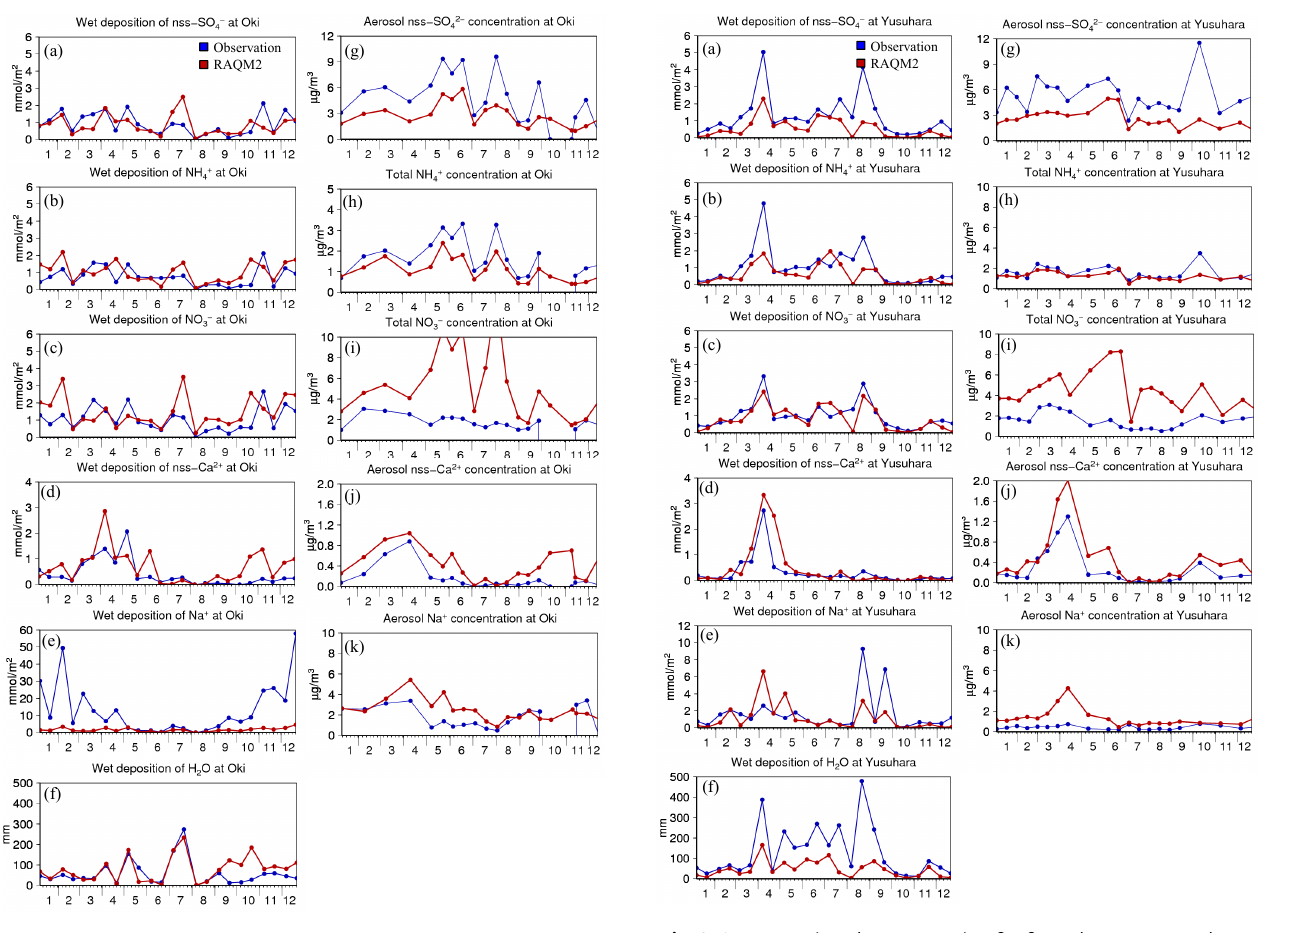
Fig. 6. Same as Fig. 5 but at a station far from the coast, Fig. 5. Biweekly mean of daily variations of the observed (blue) and simulated (red) wet deposition at a station near the coast, Oki: (a) nss-SO 2 − , (b) NH + , (c) NO − , (d) nss-Ca 2 + , (e) Na + , 4 4 3 and (f) precipitation. Biweekly variations of the observed (blue) and simulated (red) aerosol components: (g) nss-SO 2 − , (h) NH + , 4 4 (i) NO − , (j) nss-Ca 2 + and (k) Na + . 3 Figure 5.